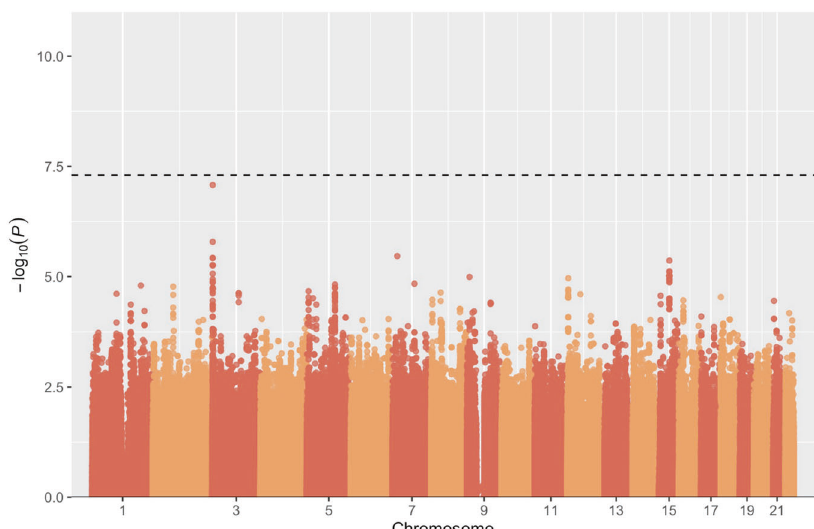
Fig. 6 Manhattan plot showing the signi fi cance of association of all SNPs across chromosomes 1 to 22 in the analysis CPT in 458 individuals. SNPs are plotted on the x-axis according to their position on each chromosome and associations with CPT are indicated on the y-axis (as − log10 P ). The dashed horizontal line marks the genome-wide signi fi cance level of 5e − 08 .